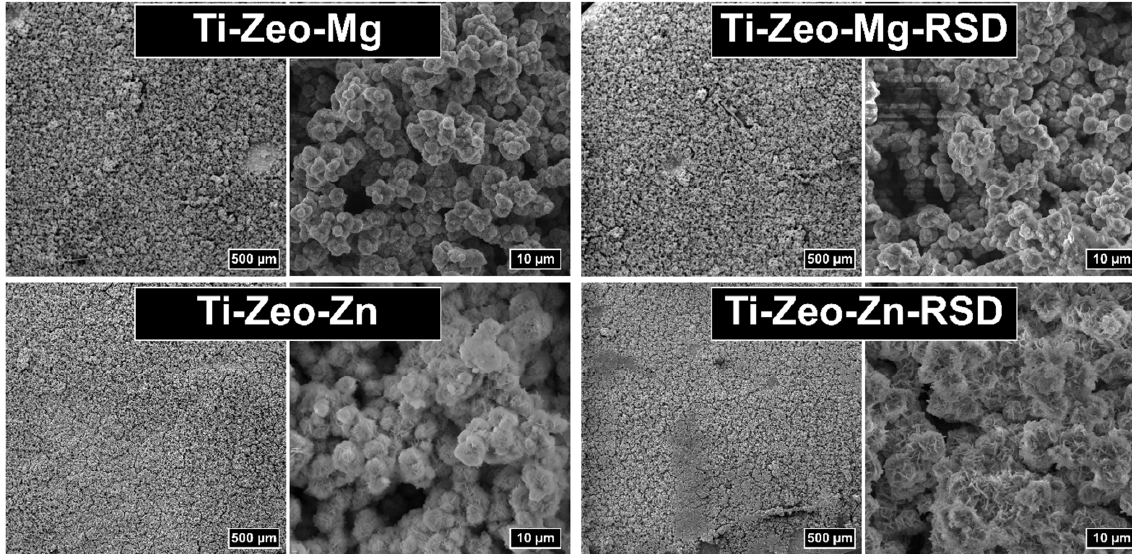
Figure 2. SEM images of the alloy with magnesium and zinc zeolite layers before and after drug adsorption.